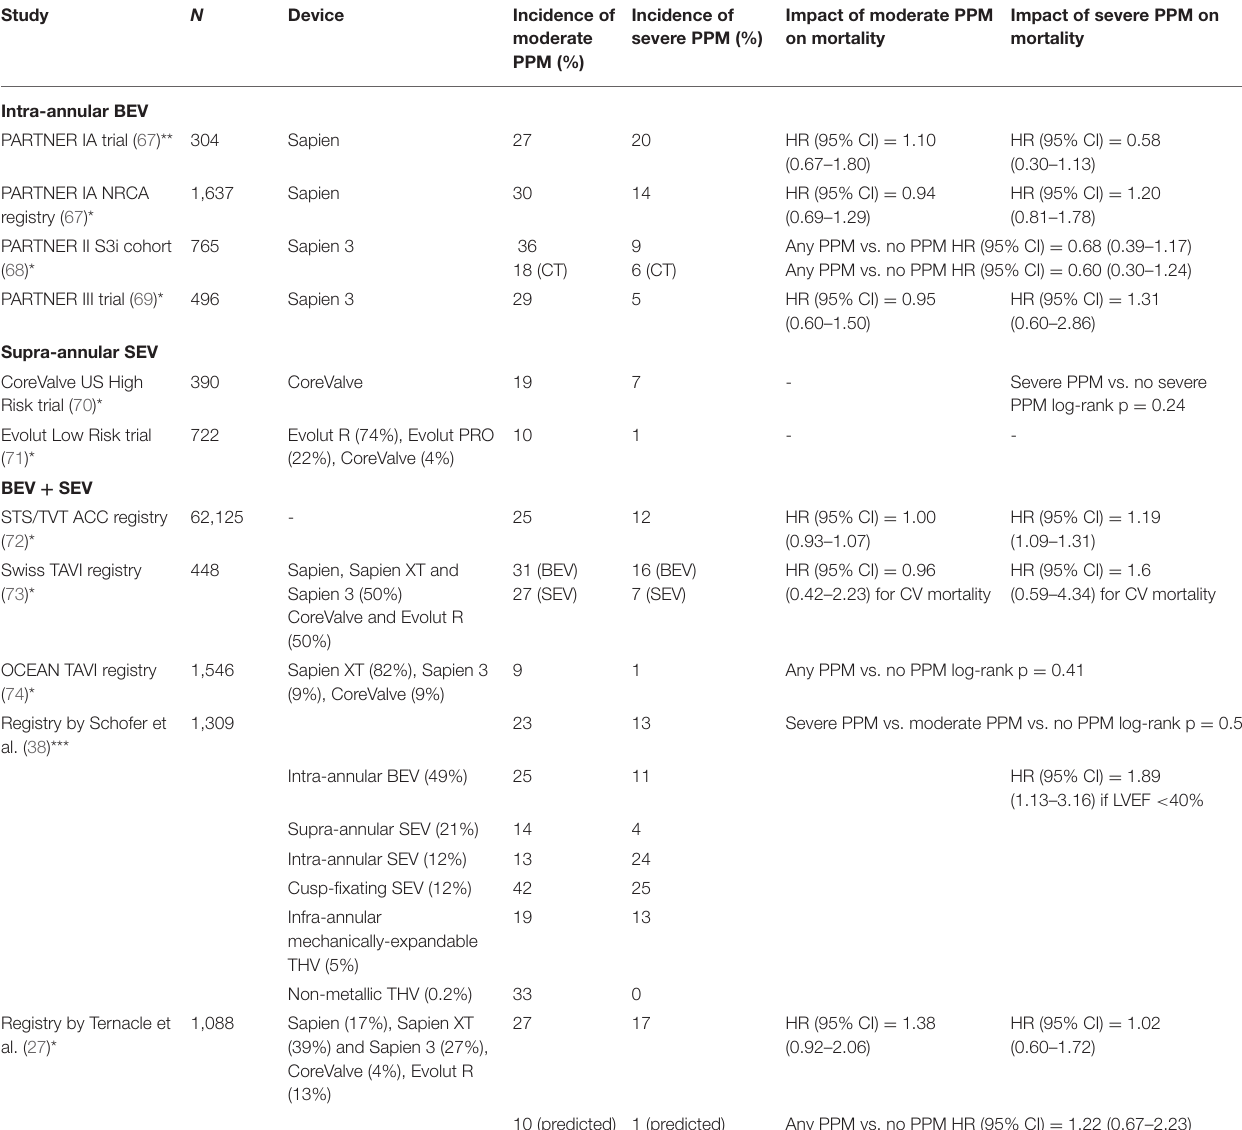
TABLE 1 | Selected studies assessing incidence and impact of PPM after TAVI. Study N Device Incidence of